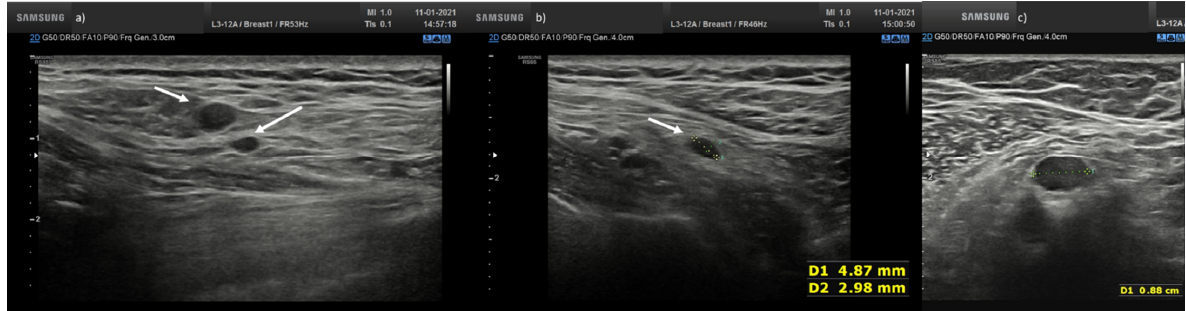
Figure 4. ( a ) Hypoechoic lymph node round shape without hilum (arrows) in laterocervical side; ( b ) Hypoechoic lymph node oval shape without hilum (arrow) in laterocervical side; ( c ) Axillary small hypoechoic lymph node oval shape without hilum (arrow).